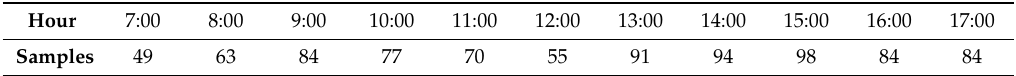
Table 2. The hourly sample